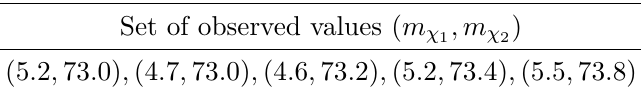
Table 1 . A set of (cid:12)ve observations for the mass pair ( m (cid:31) before creating the estimation maps to construct the median 95% con(cid:12)dence region in (cid:12)gure 5.